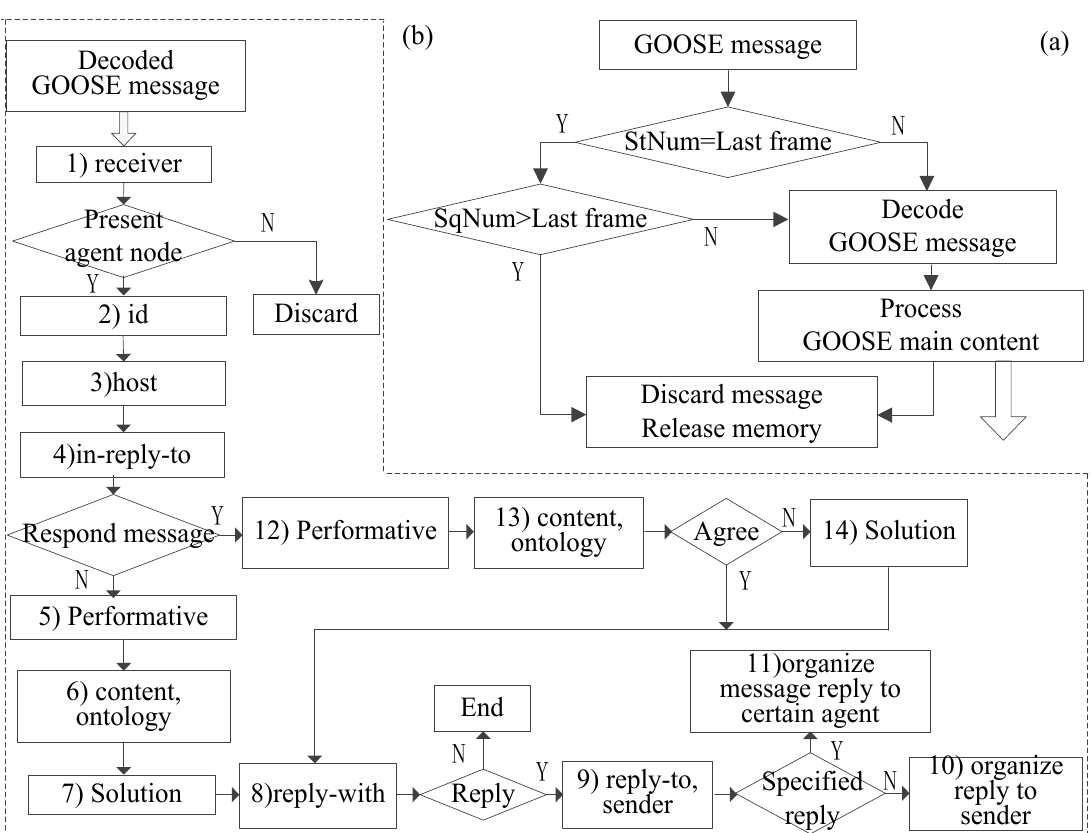
Figure A5. Workflow of decoding GOOSE message: ( a ) decoding of StNum and SqNum; and ( b ) processing of GOOSE main content.